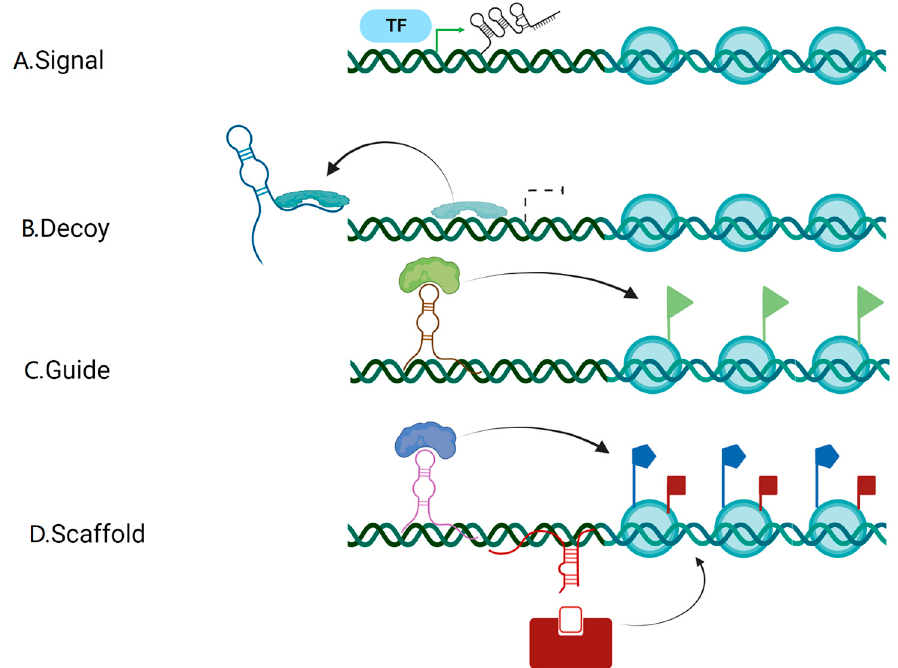
Figure 1. Biogenesis and the mode of action of lncRNAs. ( A ) Signal: some lncRNAs are specifically transcribed under different TFs and signaling pathways, and they subsequently participate in specific signaling pathways as signaling molecules. ( B ) Decoy: a certain type of lncRNAs are transcribed and bind directly to protein targets but are inactive, thus inhibiting the function of the molecule and the signaling pathway. ( C ) Guidance: certain lncRNAs, when bound to proteins, can direct the localization of ribonucleoprotein complex to specific targets (colored flags), thereby regulating the transcription of downstream molecules. ( D ) Scaffolding: some lncRNAs act as a “central platform” to bring multiple proteins together to form ribonucleoprotein complexes, enabling the intersection and integration of information between various signaling pathways and facilitating the rapid feedback and regulation of the body or cell to external signals and stimuli. (Created with